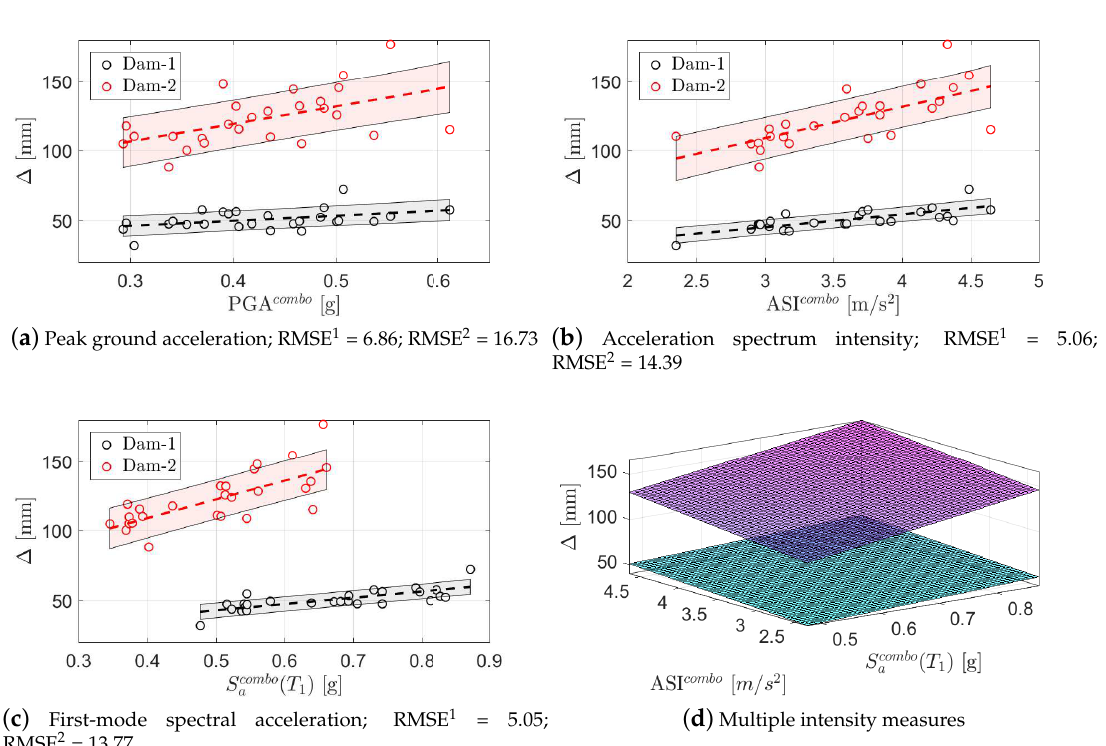
Figure 9. ( a – d ) Correlation between the dam displacement and the seismic intensity